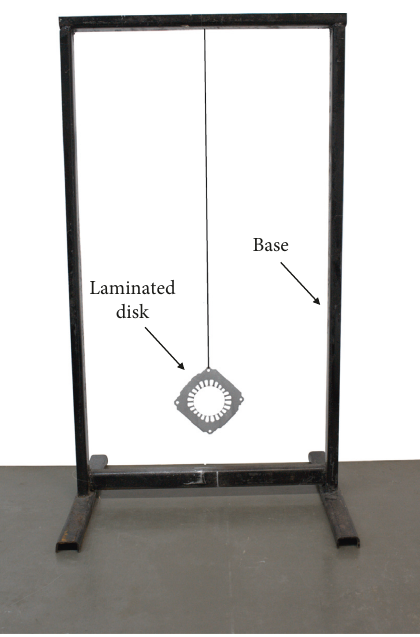
Figure 3: Experimental setup used for laminated disk